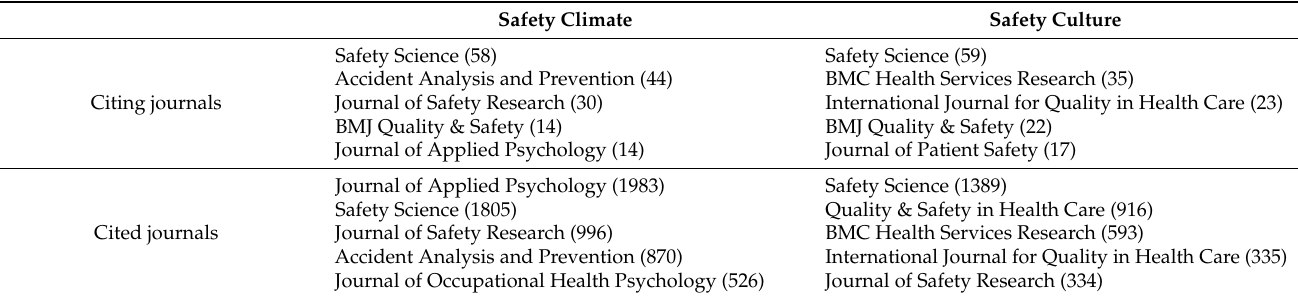
Table 5. Citing and cited journals for safety climate and safety culture